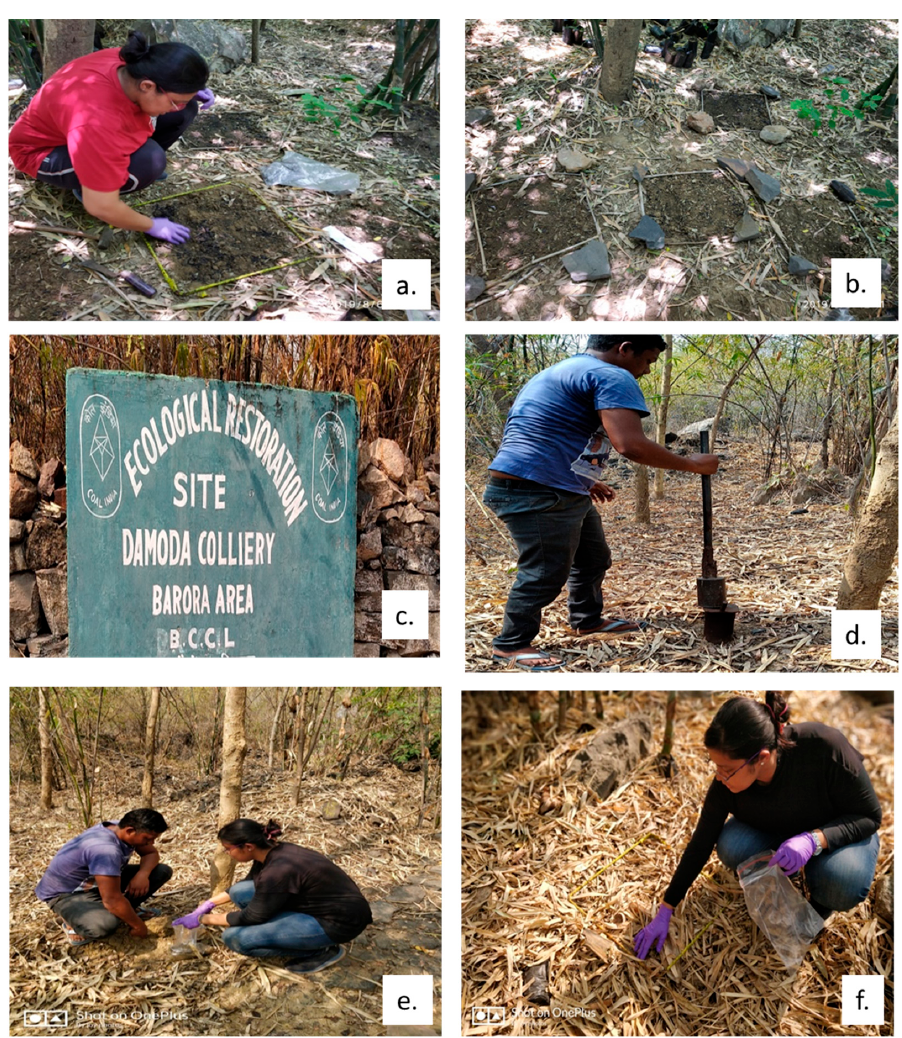
Figure 2. ( a ) Biochar being applied in RMS, ( b ) Plots showing biochar application (50 cm × 50 cm × 10 cm), ( c ) Ecological restoration project site of Damoda, showing boundary wall and sign board, ( d ) Soil sampling being done by a soil corer (80 cm × 20 cm), ( e , f ) Collection of litter from a metal quadrat (50 cm × 50